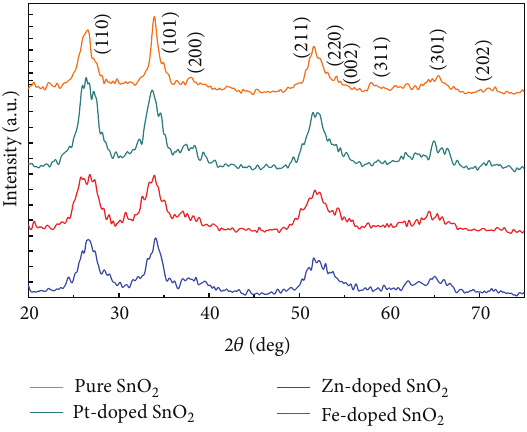
Figure 1: XRD patterns of pure, Pt-, Fe-, and Zn-doped SnO 2